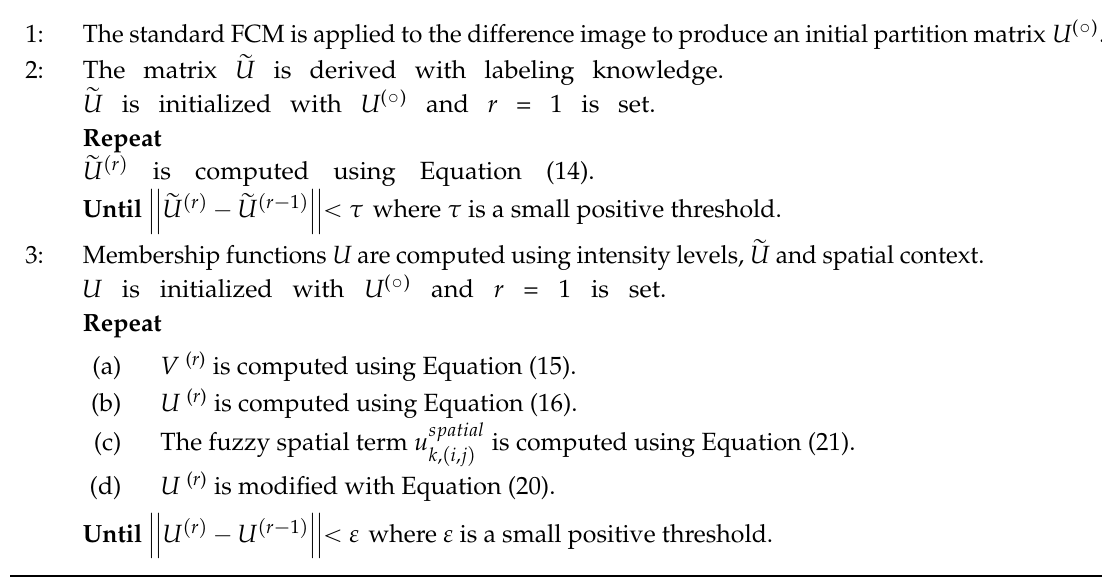
Algorithm 1 Main steps of the RSFCM clustering